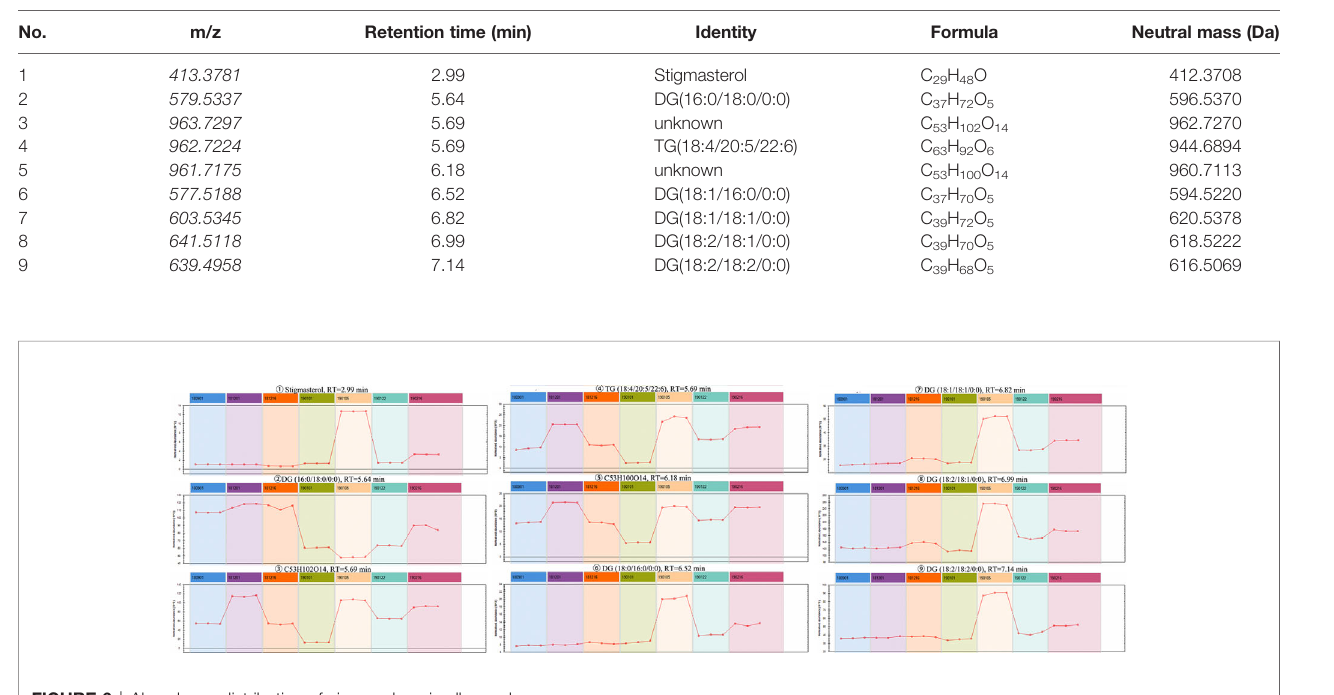
FIGURE 6 | Abundance distribution of nine markers in all samples.